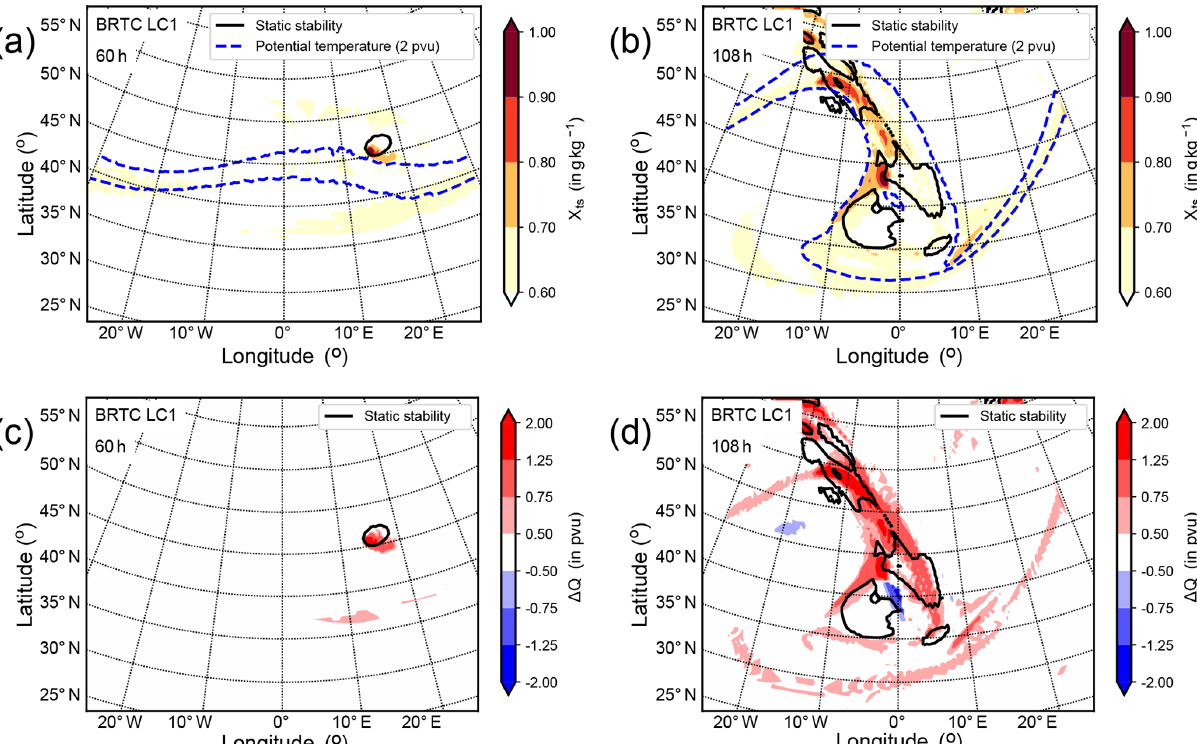
Figure 10. The tropospheric tracer X ts on first full stratospheric level, i.e., the first full level with PV values larger than 2pvu for (a) 60h and (b) 108h after model start. Diabatic change of PV, (cid:49)Q = Q − Q 0 , adv , at the level of the dynamic tropopause with Q 0 , adv being the advected initial PV and Q being the full PV for (c) 60h and (d) 108h after model start. The black isoline shows static stability, N 2 = 5 . 5 × 10 − 4 s − 2 . The blue dashed lines show isolines of potential temperature for 315 and